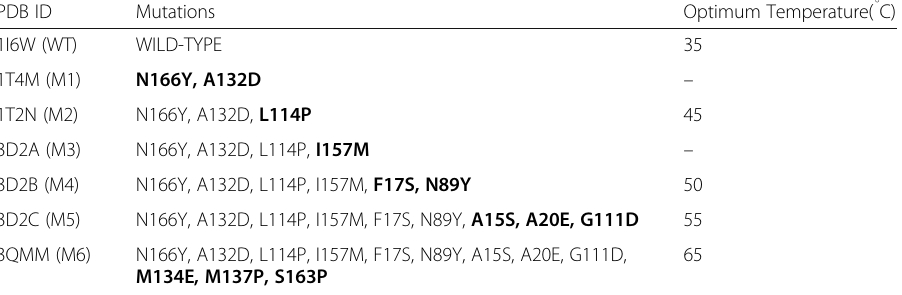
New mutations are highlighted in